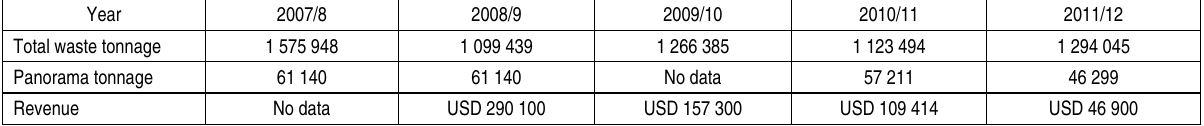
Table 1. Annual tonnage of green garden waste and revenue generated by the Panorama